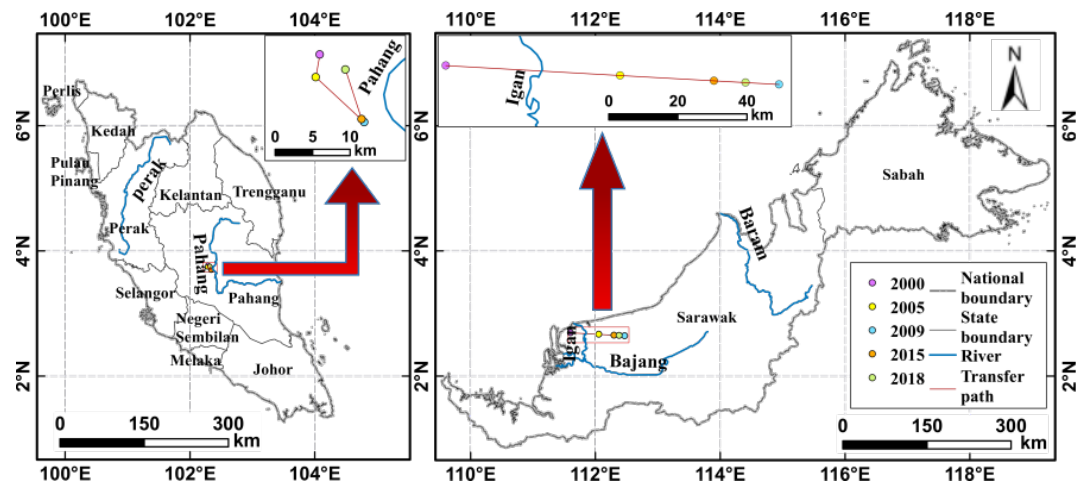
Figure 8. Oil palm planting center of gravity transfer path.